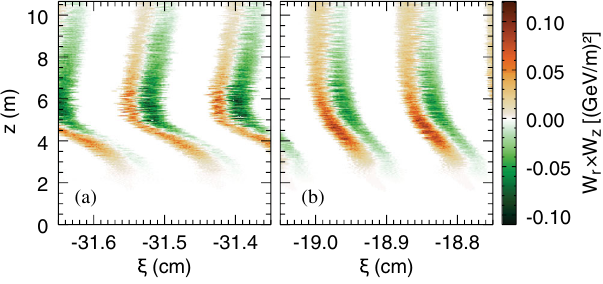
FIG. 3. Waterfall plots of the line-outs of E z on the axis along the propagation distance z for two different regions of the wakefields, (a) ξ ≈ − 2 . 5 σ zb and (b) ξ ≈ − 1 . 5 σ zb , where ξ is defined with respect to the position of the seed.